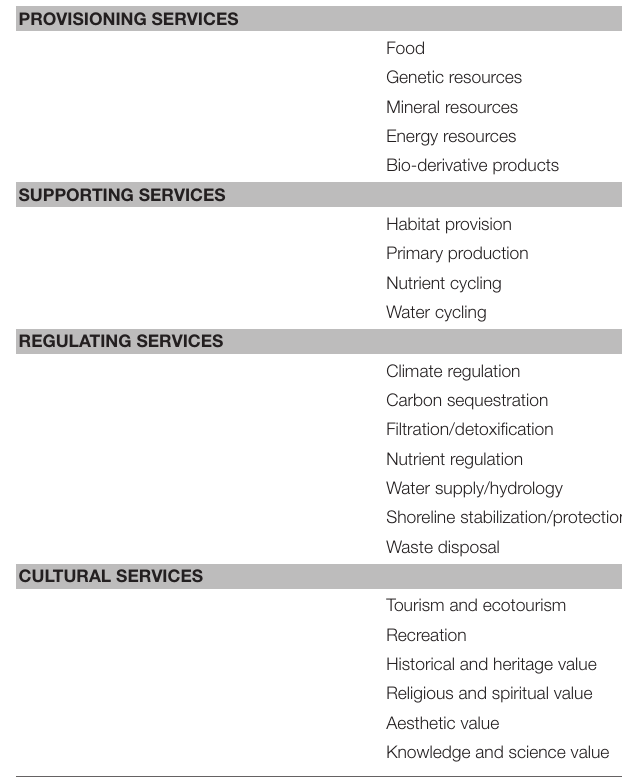
TABLE 2 | A listing of ocean ecosystem goods and services (EGS) by